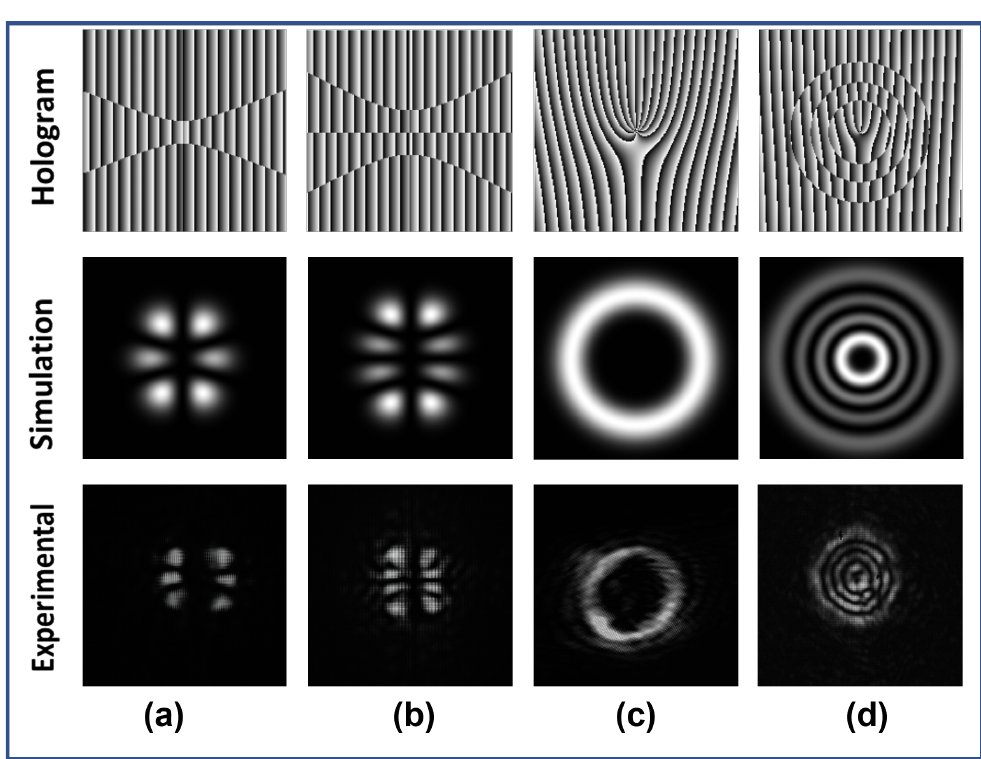
Figure 12. Holograms (first row) of superposition of different IG beams. Simulation (second row) and experimental (Third Row) intensity profile of superposition of IG beams ( a ) IG e ( b ) IG o + IG o for (cid:101) = 2, ( c ) IG o 4,4 4,2